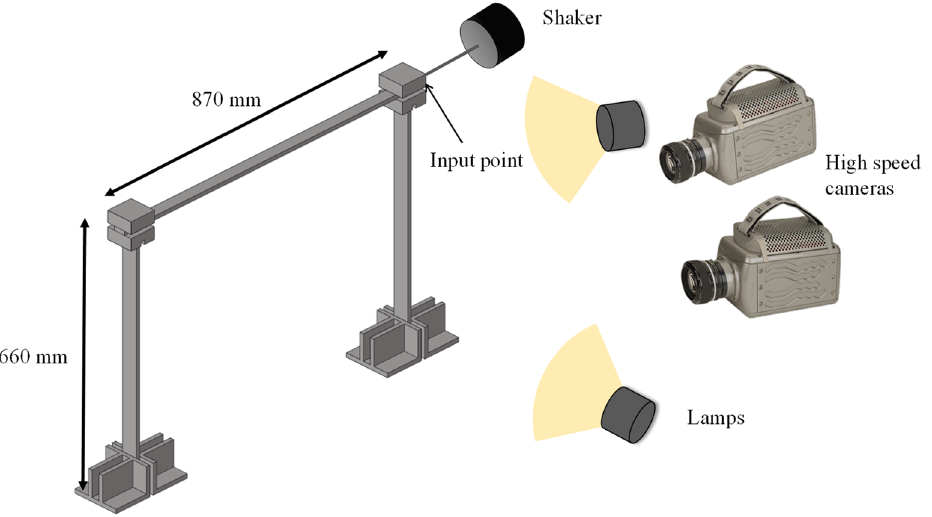
Figure 4. Scheme for broadband excitation of the frame structure and the optical arrangement for high-speed 3D displacement measurement.